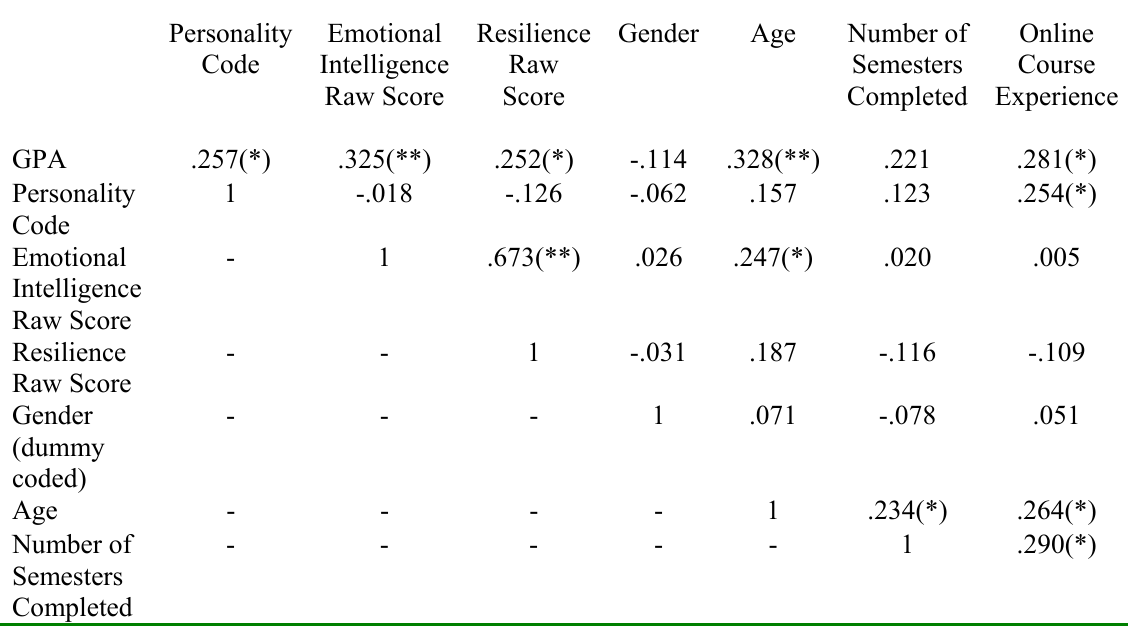
Table 1. Inter-correlations between Variables and Grade Point Average